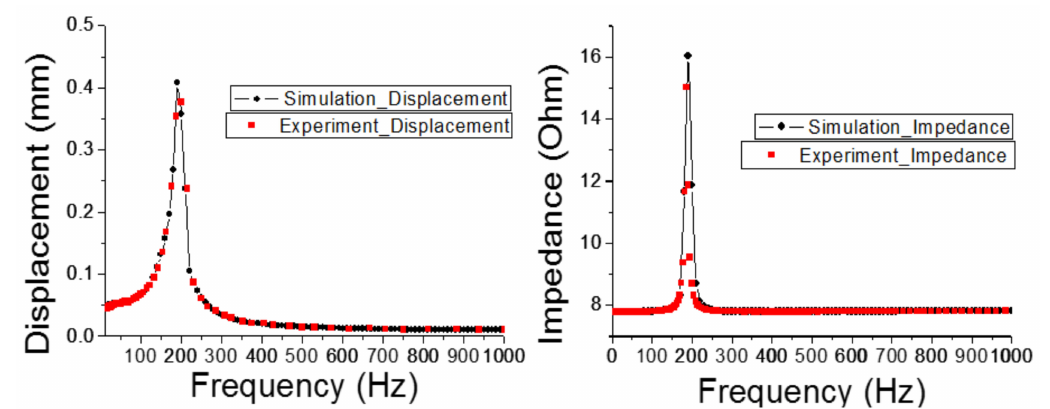
Figure 7. Comparison between simulation and experiment